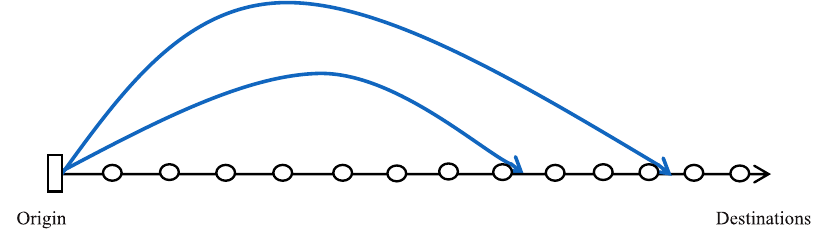
FIG. 4. ACCESSIBILITY FROM A LOCATION AT ONE END OF A